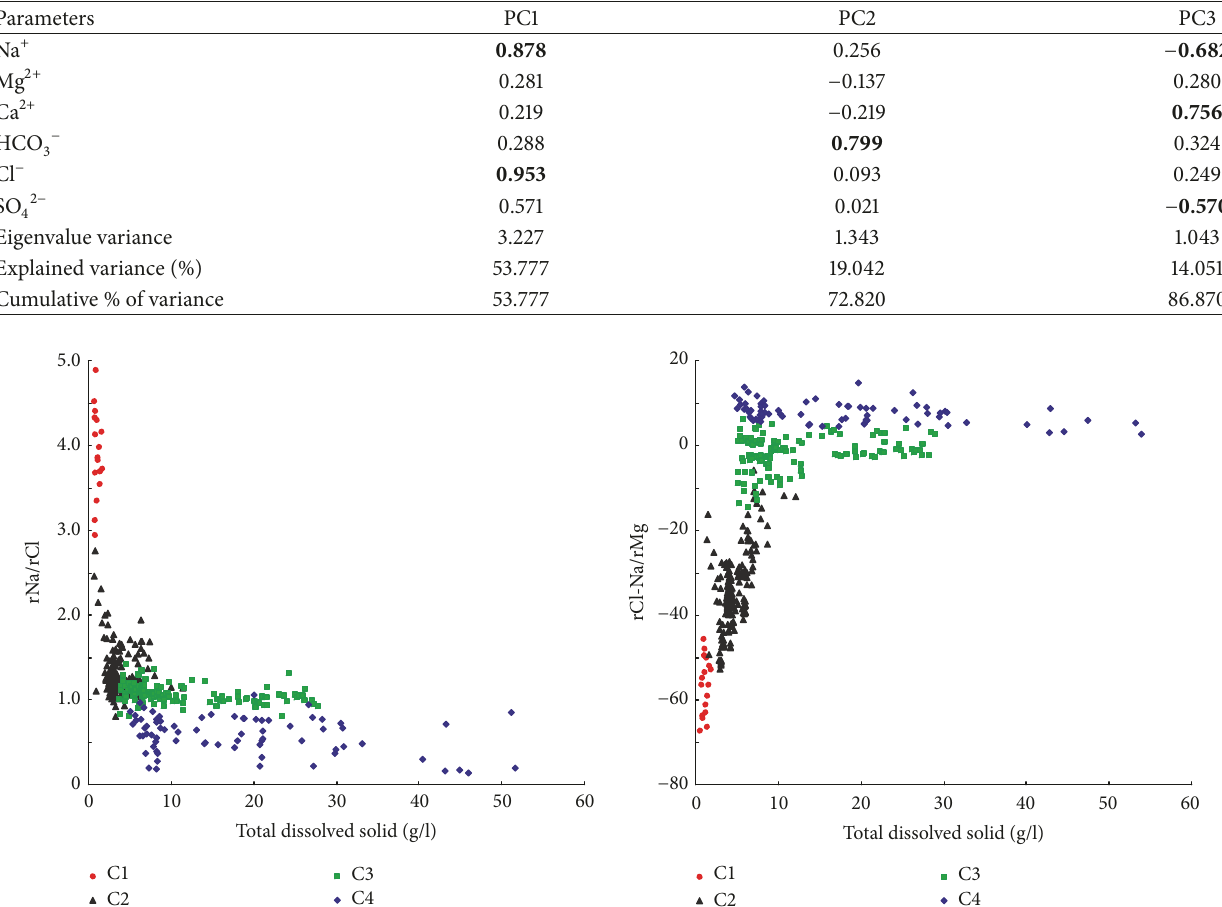
Table 2: Table of component weightings, principal component eigenvalues, and variance of principal components.